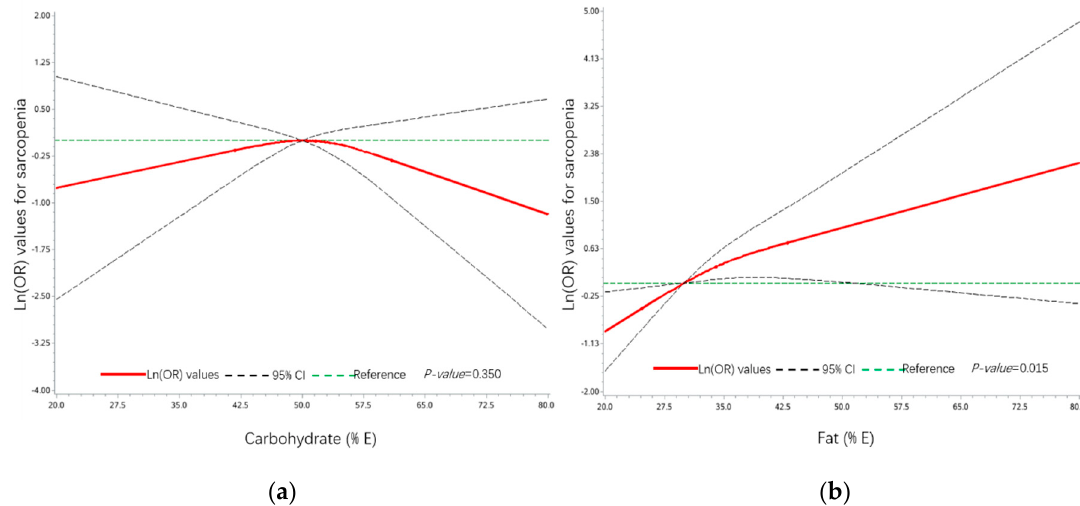
Figure 2. Associations between sarcopenia and dietary energy composition of carbohydrate and fat. ( a ) Non-linear association between sarcopenia and energy supply of carbohydrate and ( b ) non-linear association between sarcopenia and energy supply of fat. Models were adjusted by age, gender, region, BMI, exercise activity, lifestyle, dietary energy, smoke status, status of NCDs, protein amount per body weight, dietary consumption of carbohydrate and fat, and DP2 score.